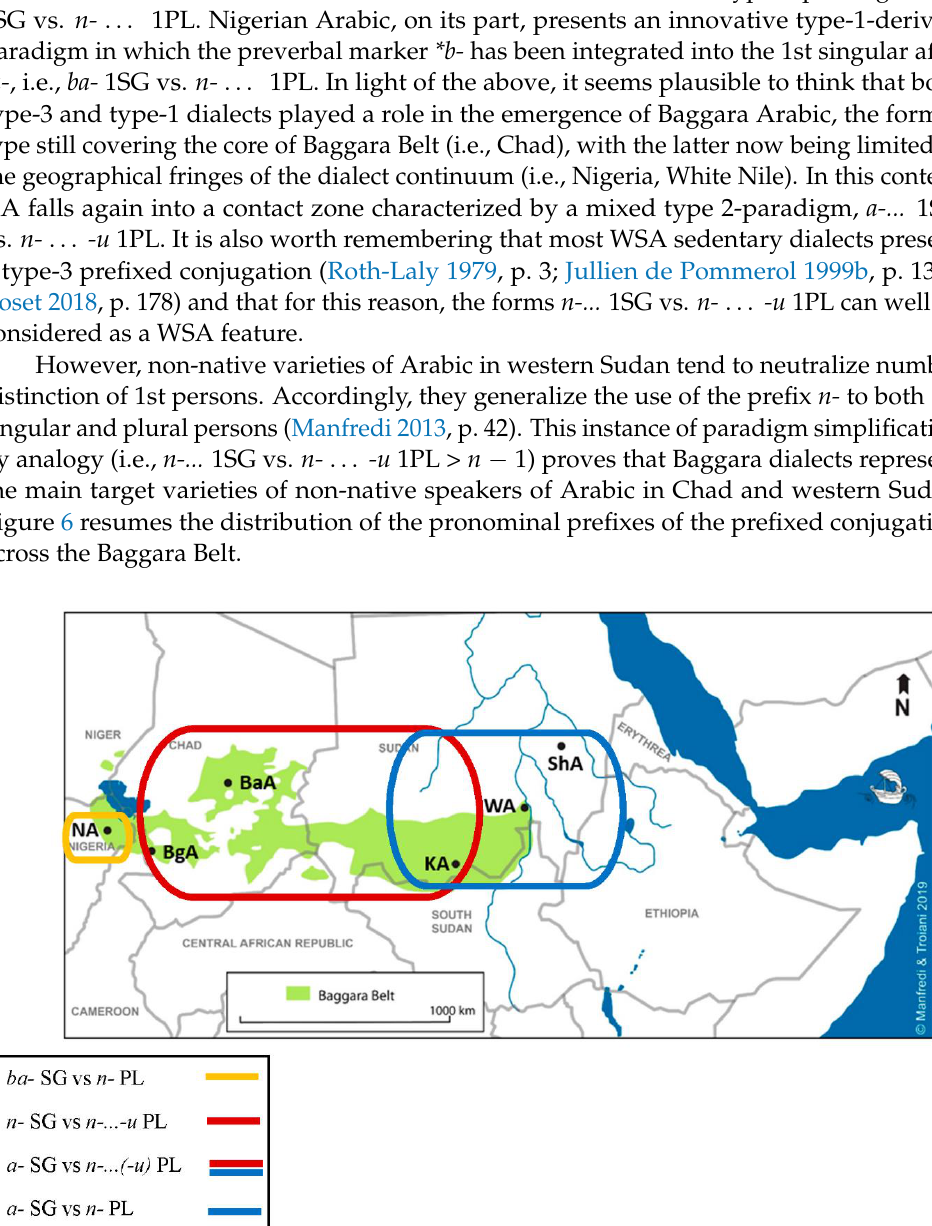
Figure 6. 1st person marking in prefixed conjugation.